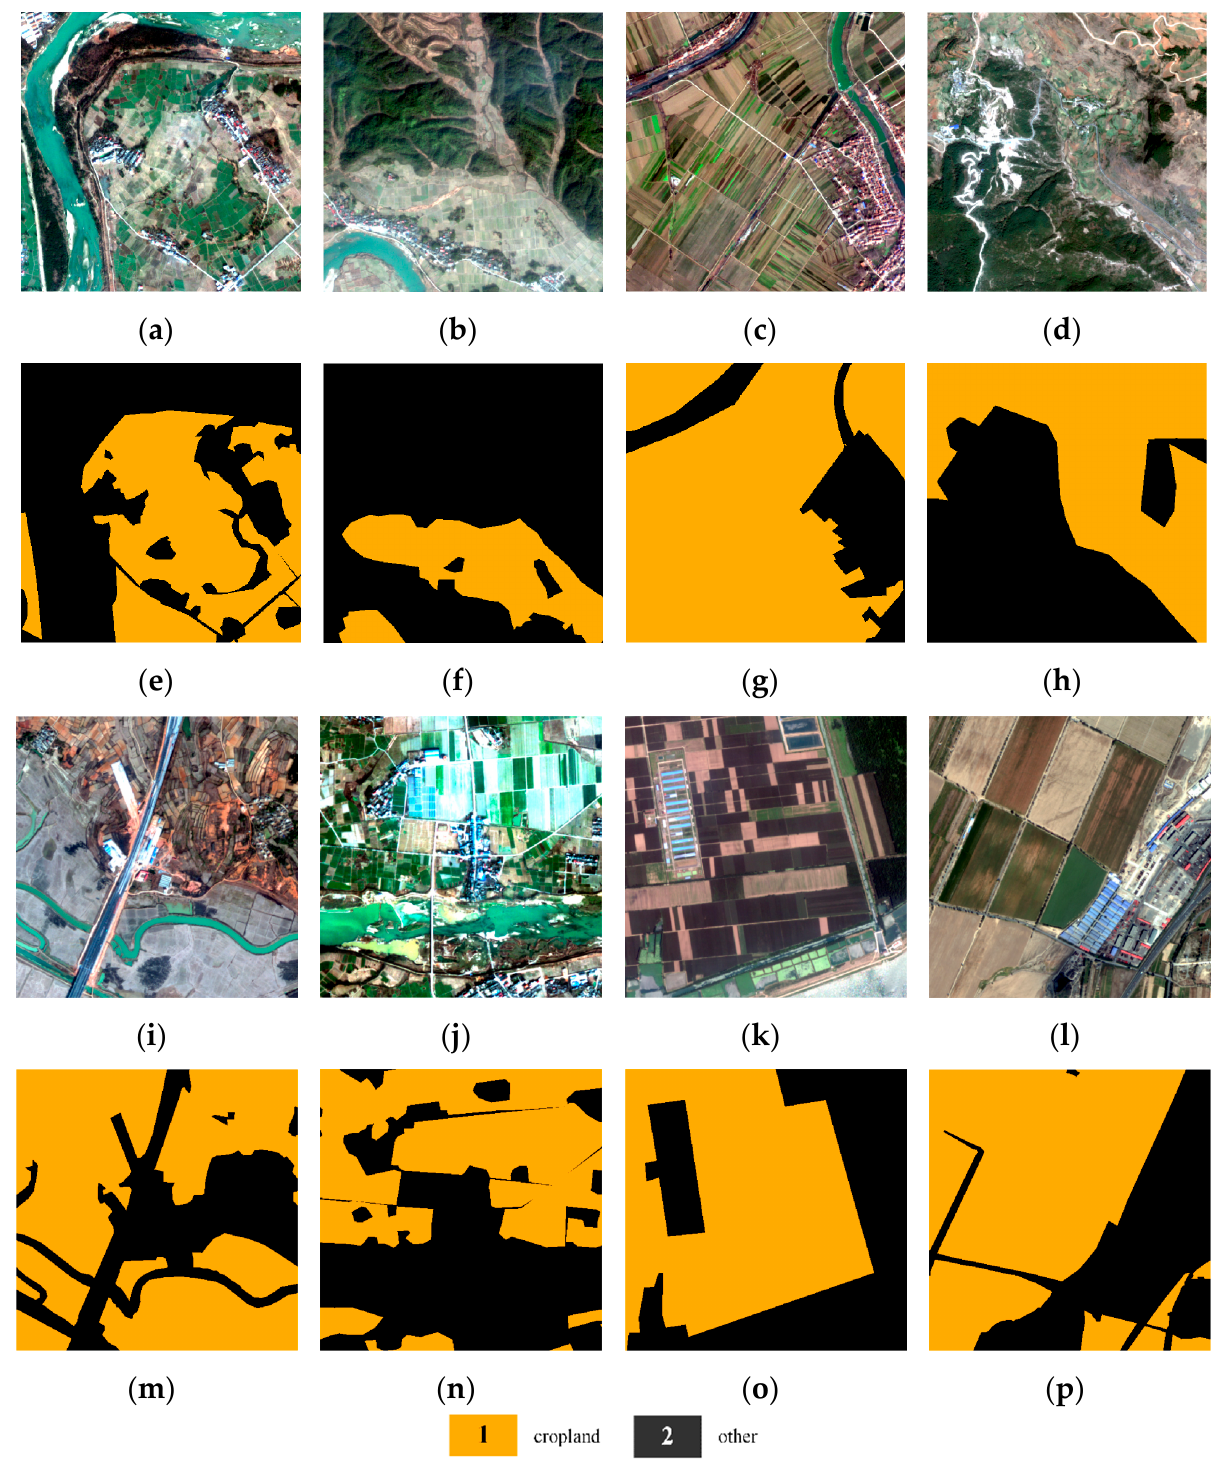
Figure 8. Cropland dataset based on the GID dataset: ( a – d ) and ( i – l ) are true ‐ color remote sensing